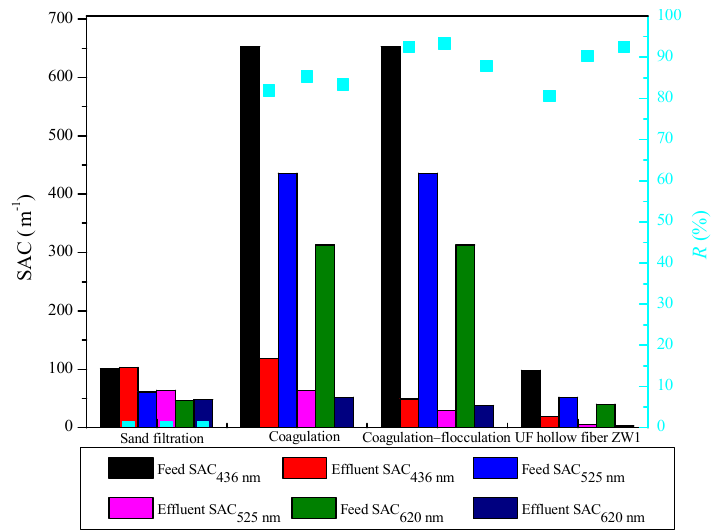
Figure 2. Color (SAC) of real TWW (feed) and investigated pretreatment effluents with removal efficiency ( R efficiency ( R ).